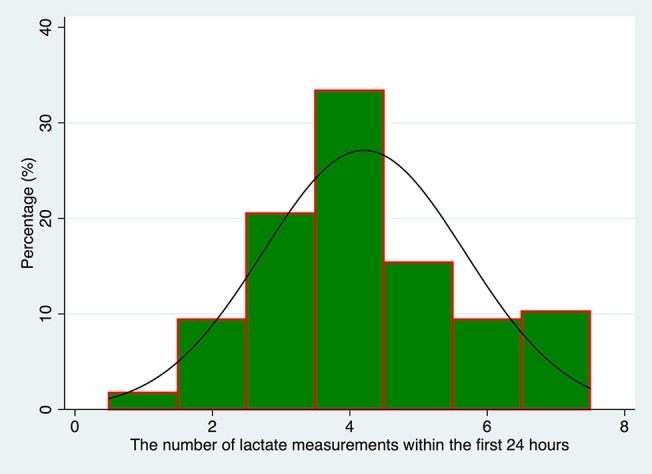
Histogram showing the number of lactate measurements within the first 24 hours.